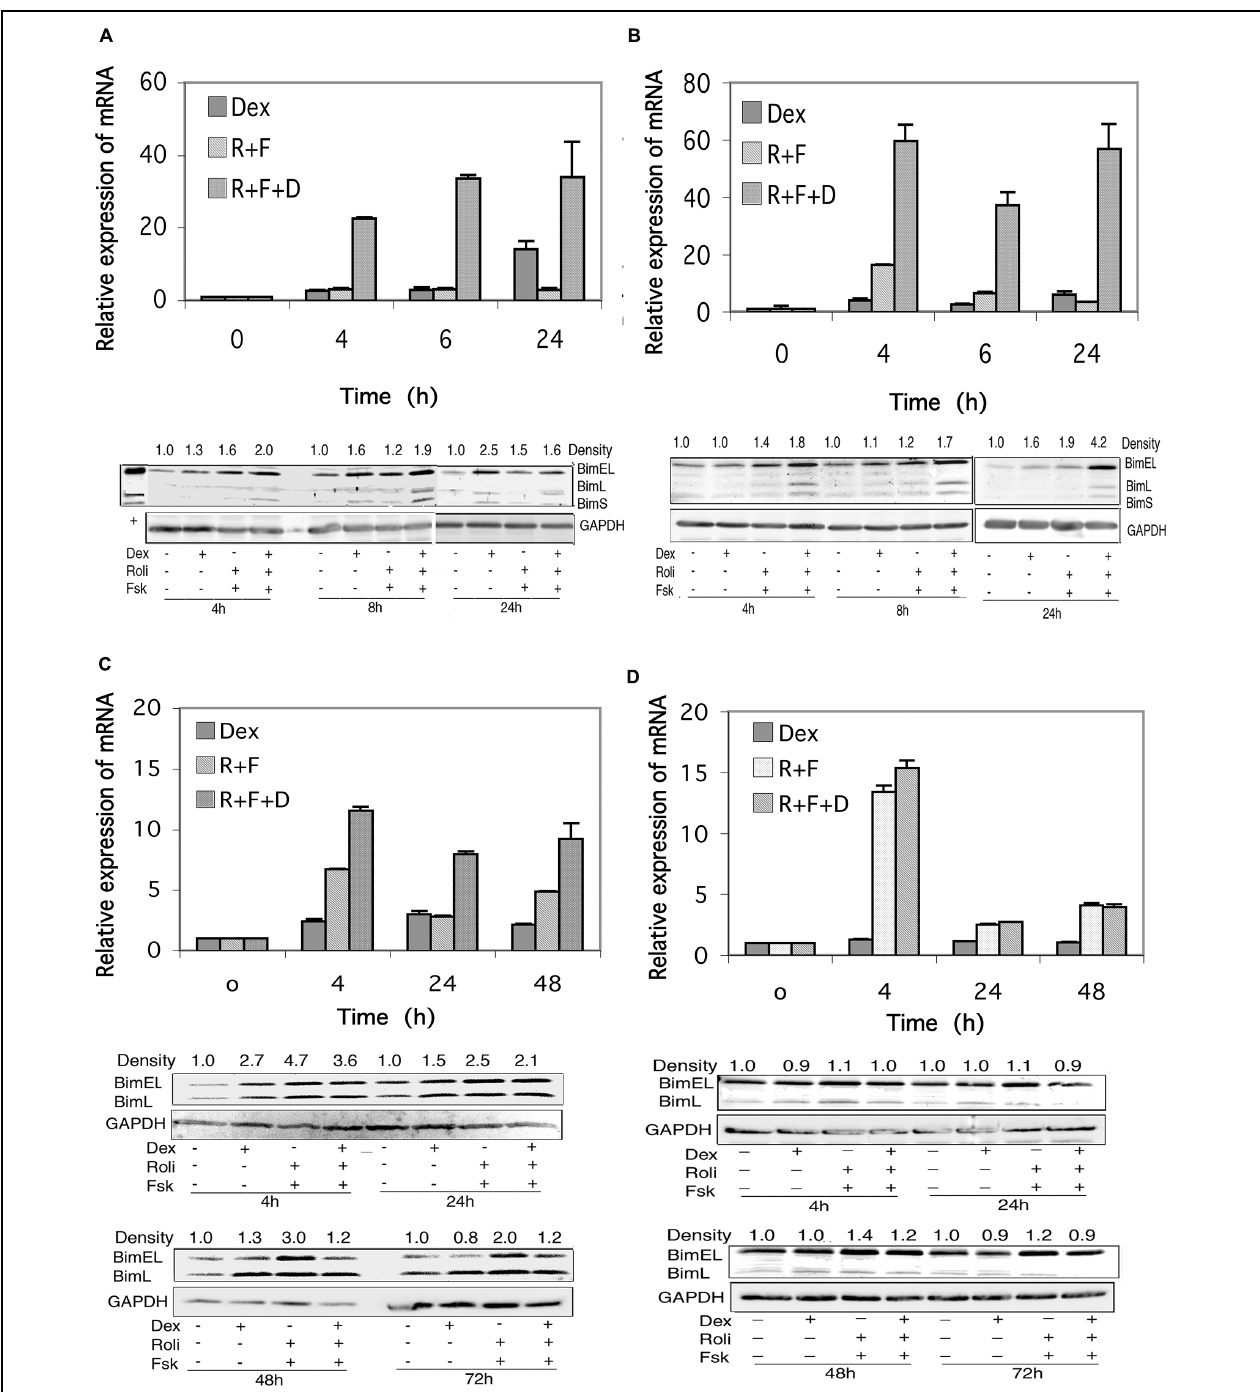
FIGURE 5 | Bim expression in CEM and MM.1 cells. (A) Quantitative real-time PCR analysis of Bim mRNA expression in CEM-S2 cells (top), at different times following treatment with 1 µ M dexamethasone (Dex), 10 µ M rolipram plus 10 µ M forskolin (R + F) or 1 µ M dexamethasone plus 10 µ M rolipram plus 10 µ M forskolin (R + F + D) as indicated. Data represent the mean ± SD of at least two independent experiments assayed in triplicate, shown as fold change relative to control. (bottom), Western blot analysis of expression of Bim protein. Cells were treated at different times with dexamethasone and/or rolipram and forskolin as indicated, and Bim protein expression was determined by immunoblots of whole cell lysates. Equal amounts of protein (20 µ g) were loaded per lane. Data shown represents one of at least two independent experiments with similar results. The numbers at the top of the Western blot images represent the BimEL band densities following different treatments relative to control, normalized based on the density of the GAPDH housekeeping protein, calculated as described in Section “Materials and Methods.” (B) CEM-R8 cell Bim mRNA (top) and protein (bottom) expression. (C) Bim mRNA (top) and protein (bottom) expression in MM.1S cells. (D) Bim mRNA (top) and protein (bottom) expression in MM.1R cells. Conditions were as in (A) .